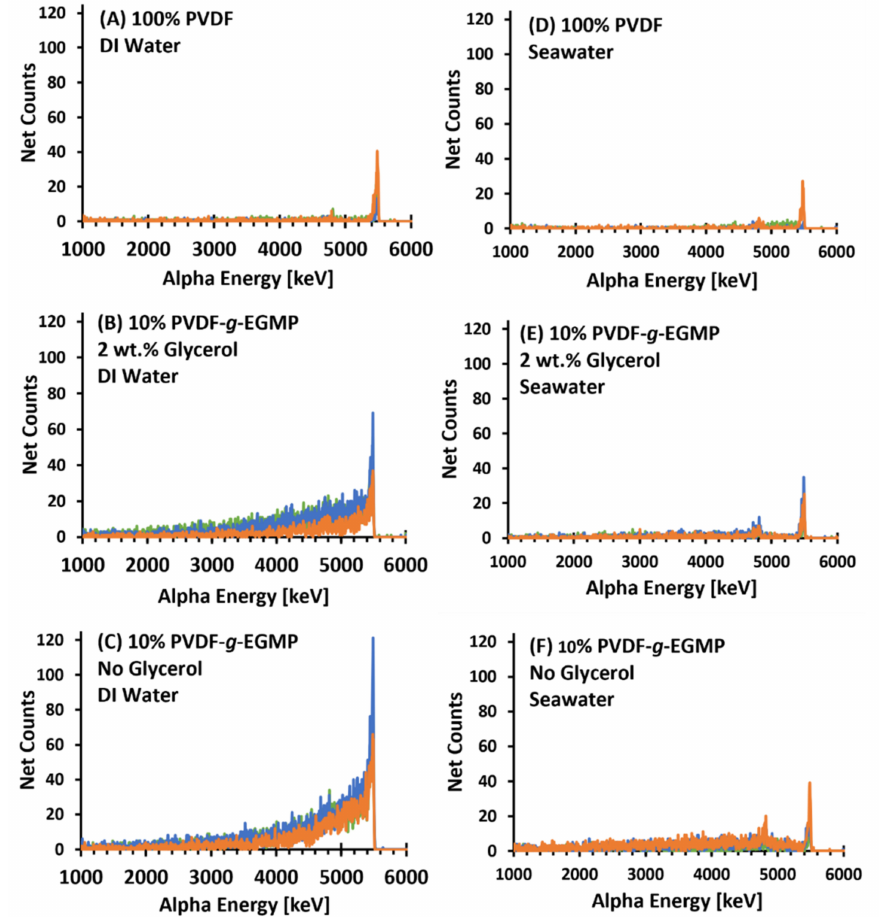
Figure 5. Five-hour alpha spectra of 100% PVDF, 10 wt% PVDF- g -EGMP (2 wt% glycerol), and 10 wt% PVDF- g -EGMP (no glycerol) membranes after direct filtration of Pu-bearing solutions. Measurements were taken after filtering 10 mL of DI water (Spectra A – C , 0.48 Bq/mL 238 Pu, pH 6.61) and synthetic seawater (Spectra D – F , 0.51 Bq/mL 238 Pu, pH